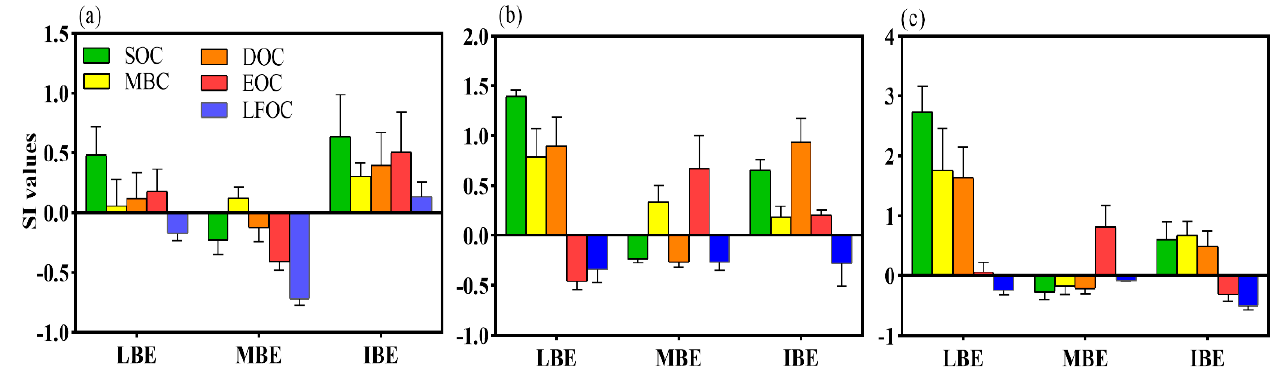
Figure 5. Sensitivity index (SI) of SLOCFs at different bedrock exposure rates. LBE (light bedrock exposure); MBE (moderate bedrock exposure); IBE (intense bedrock exposure). ( a – c ) Soil depths of 0–10 cm, 10–20 cm, and 20–30 cm, respectively. Table 1. Soil liability of carbon (L), liability index (LI), carbon pool management index (CPMI), and carbon pool index (CPI) in karst rocky desertification areas with different bedrock exposure rates. Measures